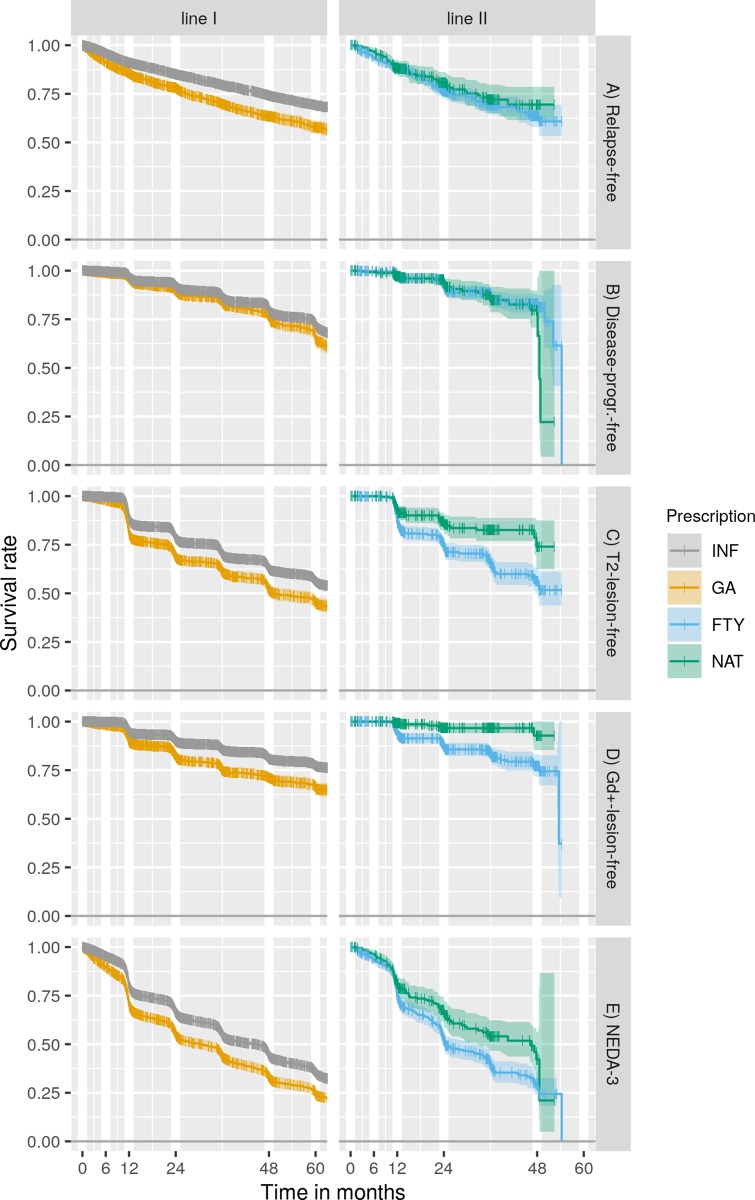
KM survival curves.A: Relapse-free survival rate B: Disease-progression-free survival rate progression C: T2-lesion-free survival rate D: Gd+-lesion-free survival rate E: NEDA-3 survival rate. The large confidence interval beyond 48 months observed in B, D and E in second-line treatment was due to algorithm artefact linked to low observation availability. Abbreviations: KM, Kaplan–Meier; INF, interferon beta; GA, glatiramer acetate; FTY, fingolimod; NAT, natalizumab; Gd+, gadolinium enhancement; NEDA-3, no evidence of disease activity.